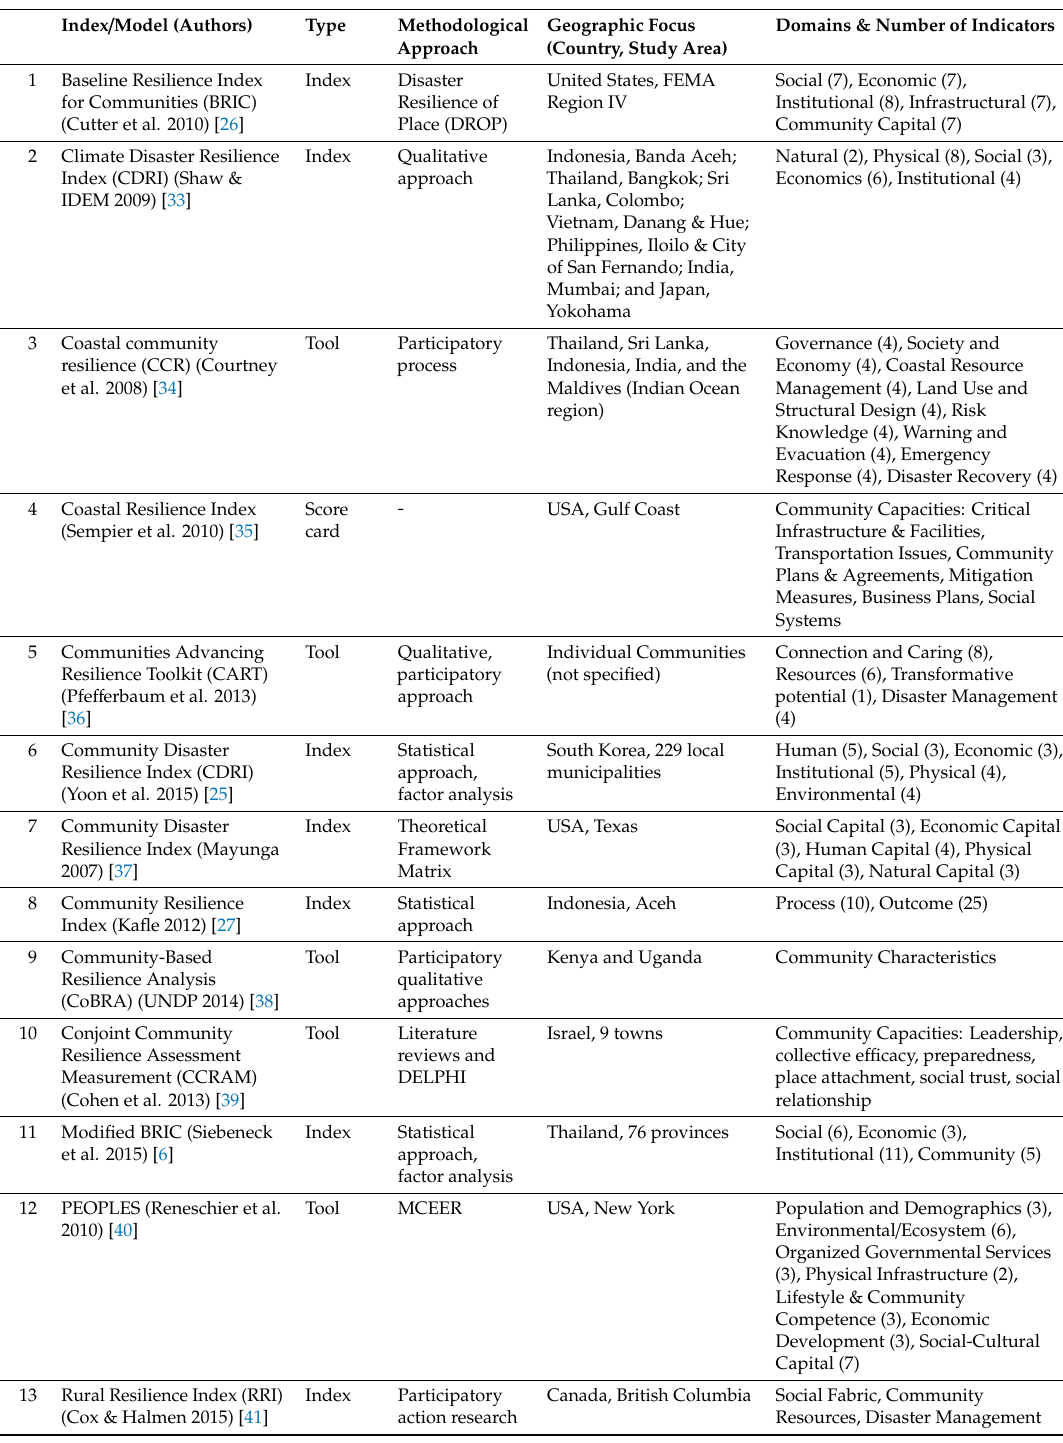
Table 2. Characteristics of selected community disaster resilience assessment